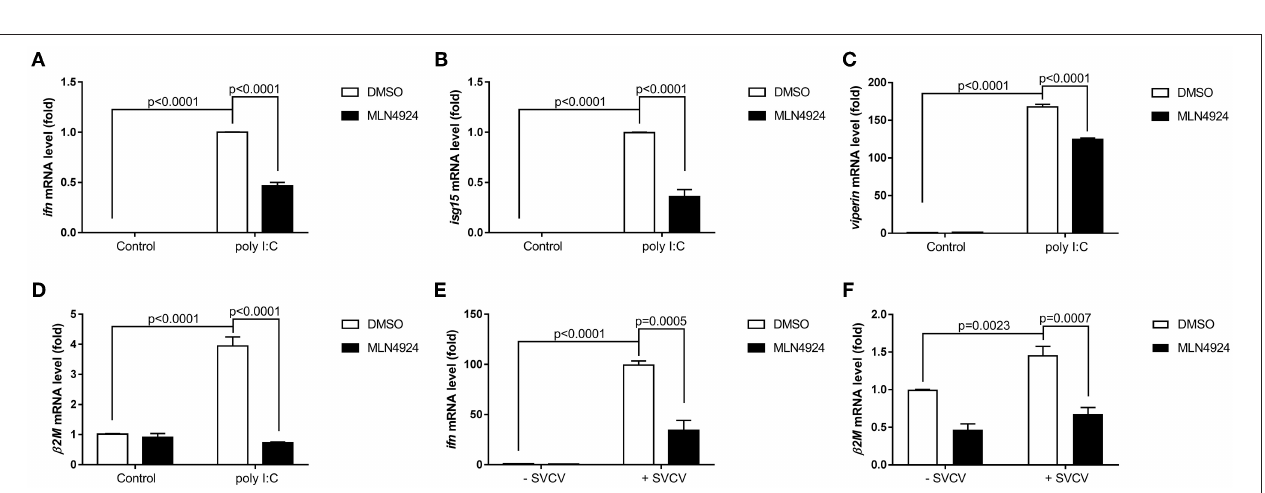
FIGURE 2 | MLN4924 suppresses the expression of key antiviral genes in EPC cells after poly(I:C) stimulation or SVCV infection. (A–D) Treatment of EPC cells with 1 µ M MLN4924 after poly(I:C) stimulation downregulated ifn (A) , isg15 (B) , and viperin (C) , β 2m (D) . (E,F) Treatment of EPC cells with 1 µ M MLN4924 after SVCV infection downregulated ifn (E) and β 2m (F) . Data are shown as mean ± SEM of three independent experiments, each performed in triplicate; the statistical analysis was performed using GraphPad Prism 5 (unpaired t -test).